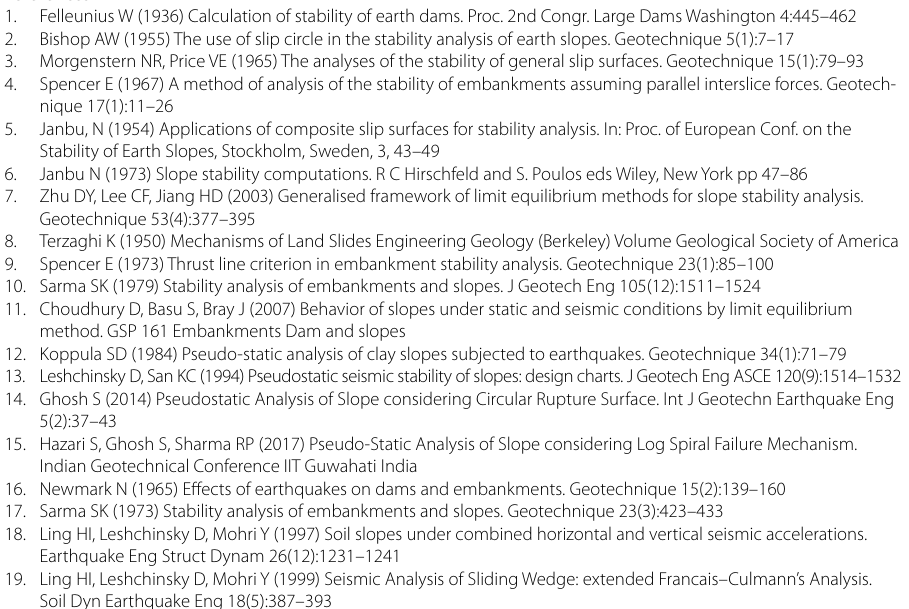
20°, k h 0.1, k v 0, φ 40°, c / γ H = = = =